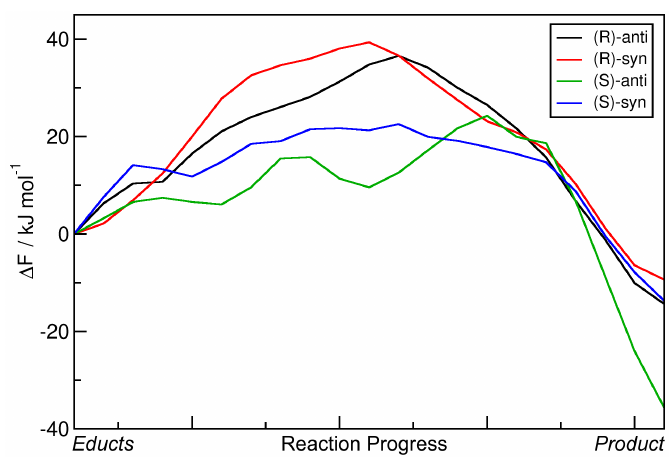
Figure 11. One-dimensional free energy profiles of aldol reactions (R=iPr) in DMF obtained from HyAIMD metadynamics; corresponds to red curves in Figure 10. Free energies are given relative to